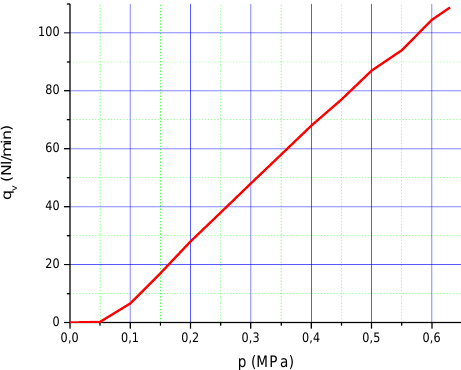
=f(p) of the valve BV309A-CD1-00- v